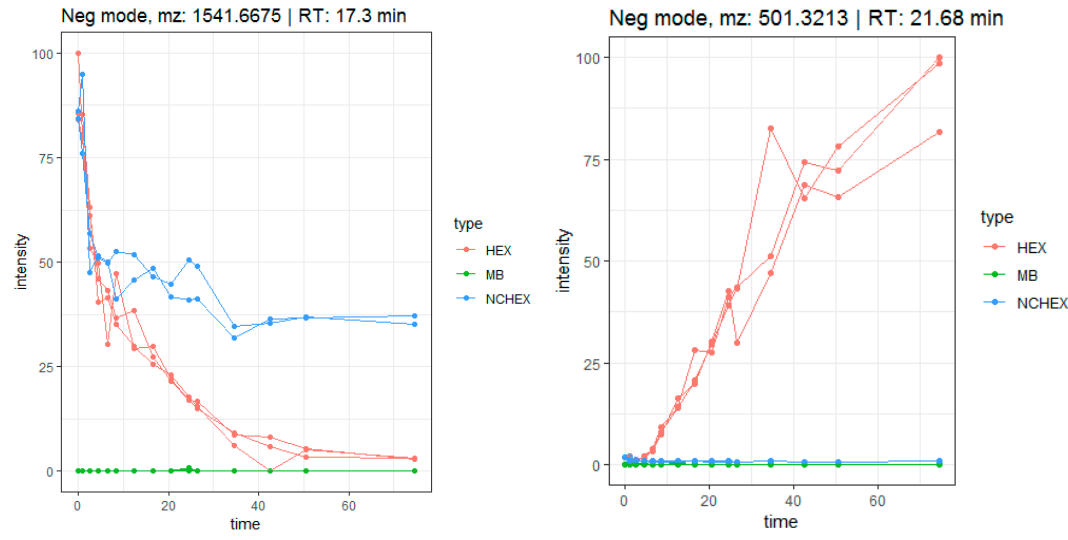
Figure 6. Time profile of gastrointestinal biotransformation of herniariasaponin H ( m / z 1541.6675 [M-H] − ) and medicagenic acid ( m / z 501.3213 [M-H] − ).